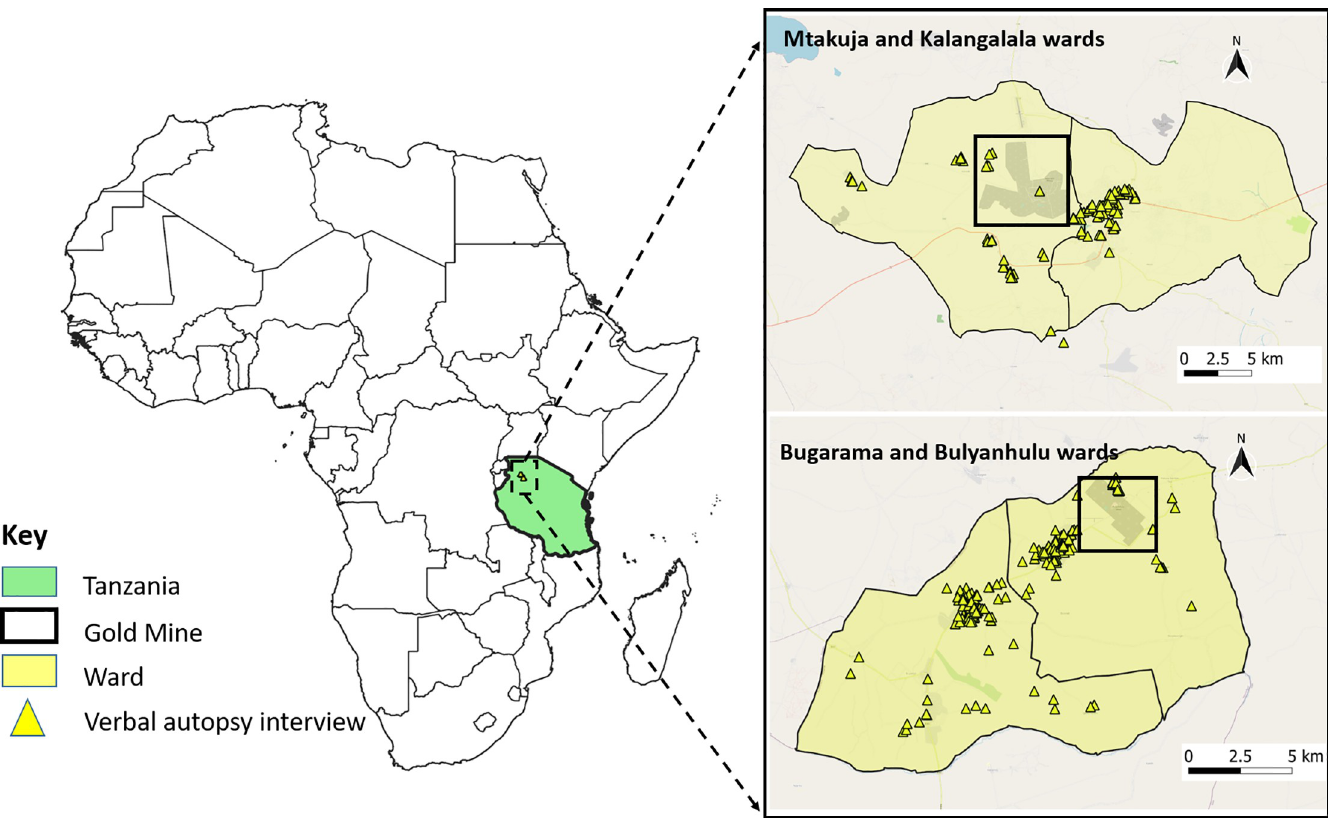
Fig 1. Location of the mining areas and the study sites (left) including location where the verbal autopsy interview occurred (right). This figure was created using QGIS, an open-source application. The source basemap was obtained using OpenStreetMap plugin in QGIS. OpenStreeMap follows open data license under Open